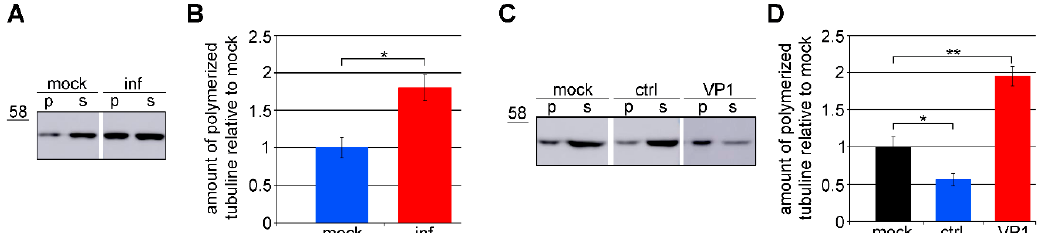
Figure 3. VP1 increases the level of microtubules in cells. ( A ) 3T6 cells were infected or ( C ) WOP cells were transfected with the control plasmid (ctrl) or with the plasmid expressing VP1 (VP1). Cells were fractionated into a polymerized (p) and soluble (s) fraction at 40 hpi or 24 hpt. These fractions were applied to SDS-PAGE, immunoblotted, and tubulin was stained by a specific antibody. ( B , D ) A graphic illustration of a densitometry analysis of the digital images of Western blots from three independent experiments. The fold increase in polymerized tubulin relative to the mock-infected / mock-transfected cells is shown. +/ − SD. * p < 0.05, ** p < 0.01 determined by Student’s t test.